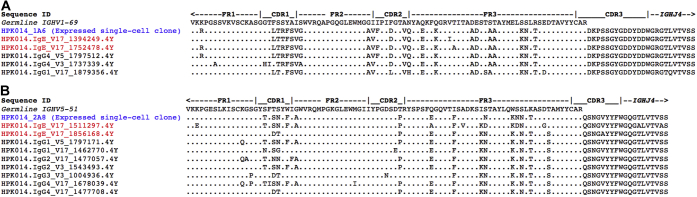
Expressed single-cell IgG1 clones with IgE relatives identified by using next-generation sequencing (NGS) of B-cell repertoire. The immunoglobulin VH gene repertoire in the nasal polyps from patient HPK-014 was captured on the Illumina 2x300 MiSeq System and bioinformatically analyzed (manuscript in preparation). The sequences in the HPK-014 NGS data set were aligned with the recombinant IgG1 antibodies expressed from 18 FACS-sorted SAE+ B cells (SAE+CD19+CD138−7-AAD−), and their clonal relatedness was determined by using clone-specific CDR3 DNA motifs. Two clonal families were identified, showing 2 expressed recombinant IgG1 antibodies (A: HPK-014_1A6 and B: HPK-014_2A8; Sequence ID in blue) related to IgE (sequence ID in red) and other IgG mutants in the HPK-014 NGS data set. For illustration purposes, not all members of the clones isolated by using NGS are shown.